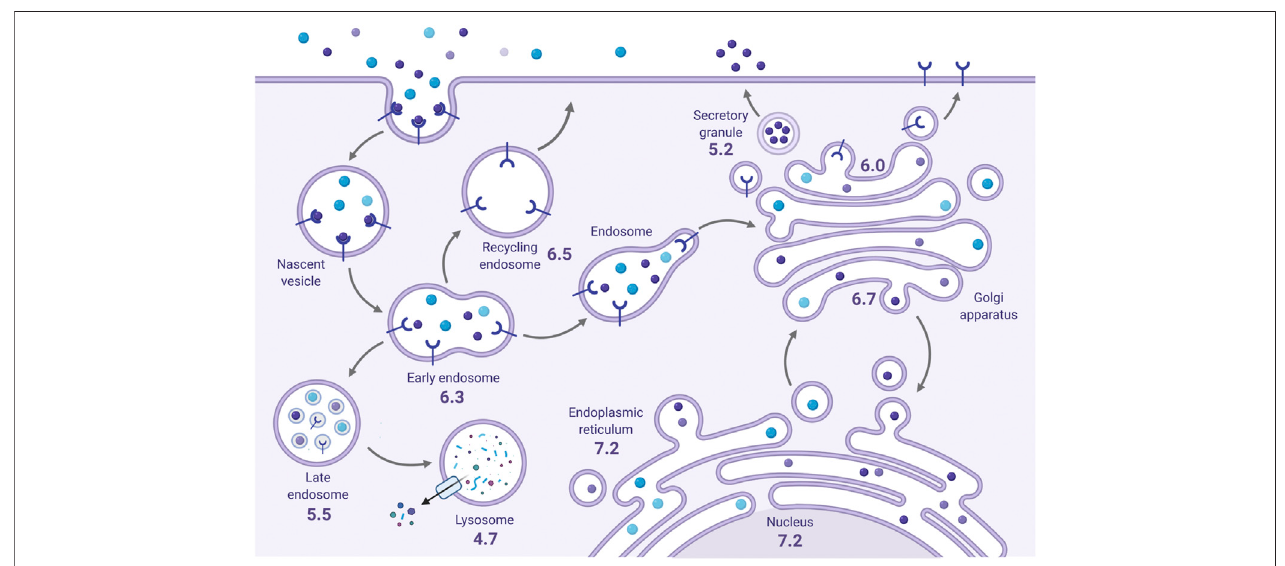
FIGURE 2 | The steady-state pH of endomembrane compartments. The average resting pH of endomembrane compartments (indicated) becomes progressively more acidic along the secretory and endocytic pathways. Created with BioRender.com.